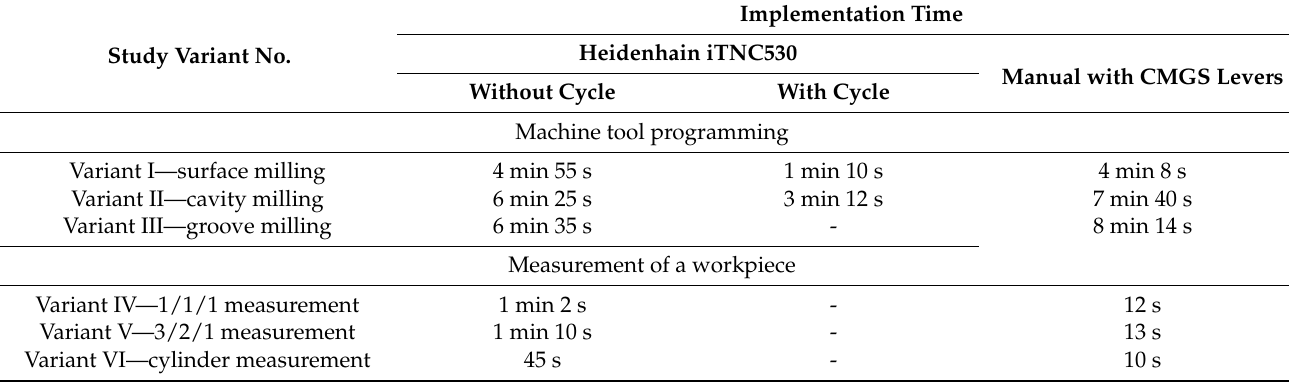
Table 1. Results of tests of functionality of the manual programming system using the CMGS system and commercially available Heidenhain iTNC530 control